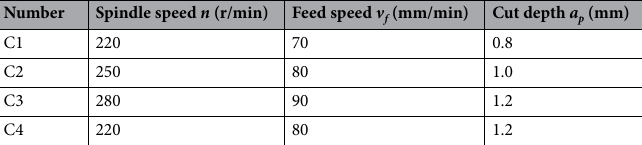
Table 3. Milling process